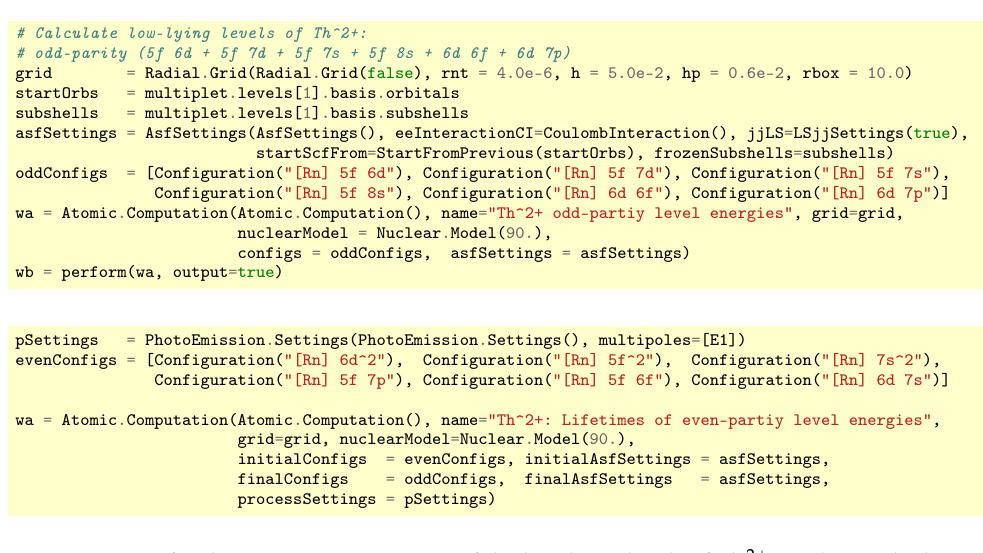
Figure 6. Input for the Atomic.Computation of the low-lying levels of Th 2 + . In these calculations ( upper panel ), the orbitals of the [Rn] 5 f 6 d configuration have first been optimized independently and then be kept frozen in the computation above. In the ( lower panel ), in addition, the transition probabilities and lifetimes are obtained by just specifying the even-parity configurations as well as the Settings for the photo